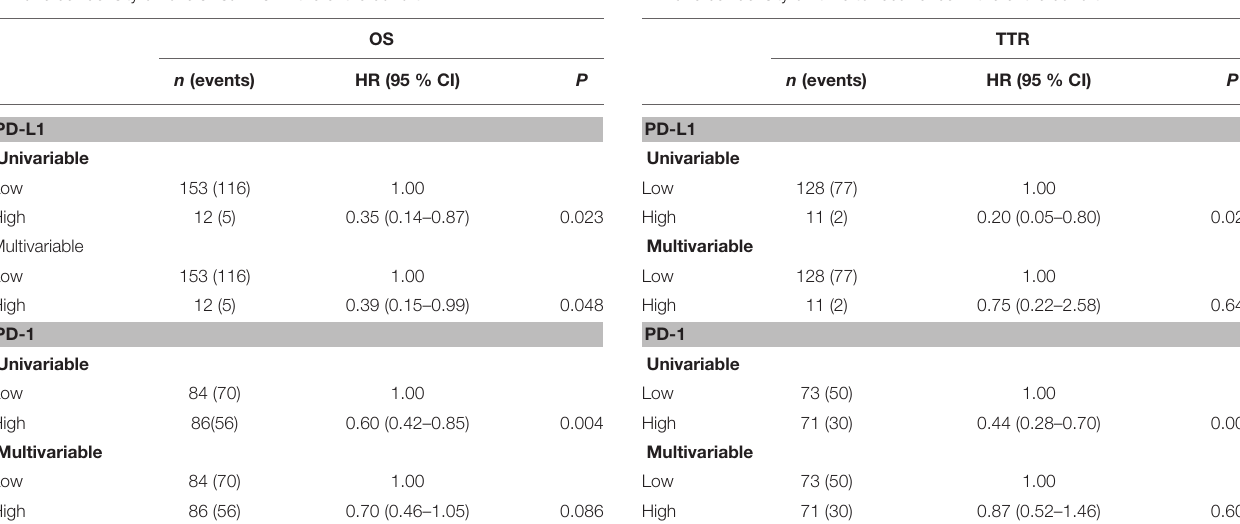
TABLE 3 | Cox proportional hazards analysis of the impact of PD-L1 and PD-1 immune cell density on time to recurrence in the entire